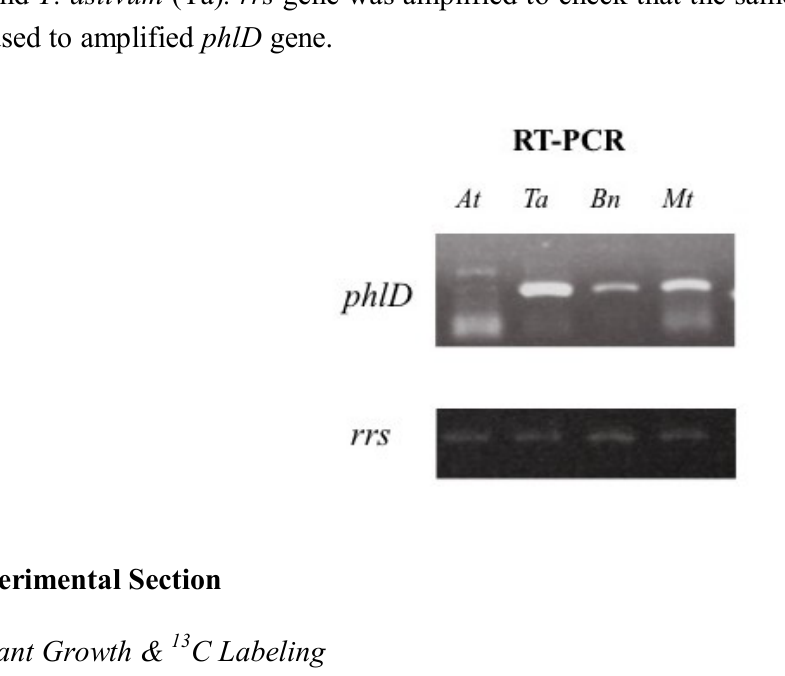
Figure 2. Modulation of phlD gene expression of Pseudomonas brassicacearum NFM421 inoculated in vitro in the rhizosphere of A. thaliana (At) , M. truncatula (Mt) , B. napus (Bn) and T. astivum (Ta) . rrs gene was amplified to check that the same amount of C-DNA was used to amplified phlD